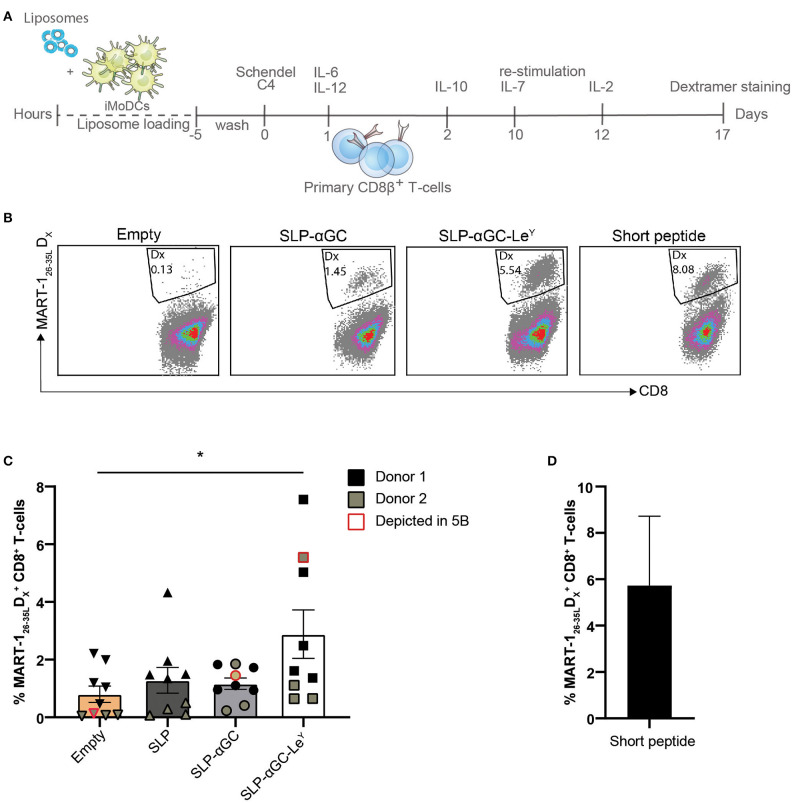
LeY liposome-loaded DC activate primary T-cells. (A) Experimental set-up for priming of T-cells through co-culture of mature DC loaded with MART-1 containing and DC-targeted or non-targeted liposomes. (B) Representative dot plots showing MART-126−35L dextramer positive CD8+ T-cells induced by Empty, SLP-αGC, SLP-αGC-LeY liposomes and short MART-126−35L peptide 17 days after induction. (C) Percentages of MART-126−35L dextramer positive T-cells after co-culture with liposome-loaded and matured DC 17 days after induction. Five wells of liposome-loaded DC and primary CD8β T-cells were initiated for donor 1 (black) and four bulks for donor 2 (olive green). Data points outlined with red indicate the cultures shown as dot plot in figure 5B. Data represents mean ± SEM, one-way ANOVA Tukey's post hoc test, * < 0.05. (D) Frequency of MART-1 specific T-cells present in control conditions after co-culture with DCs loaded with short MART-126−35L peptide.